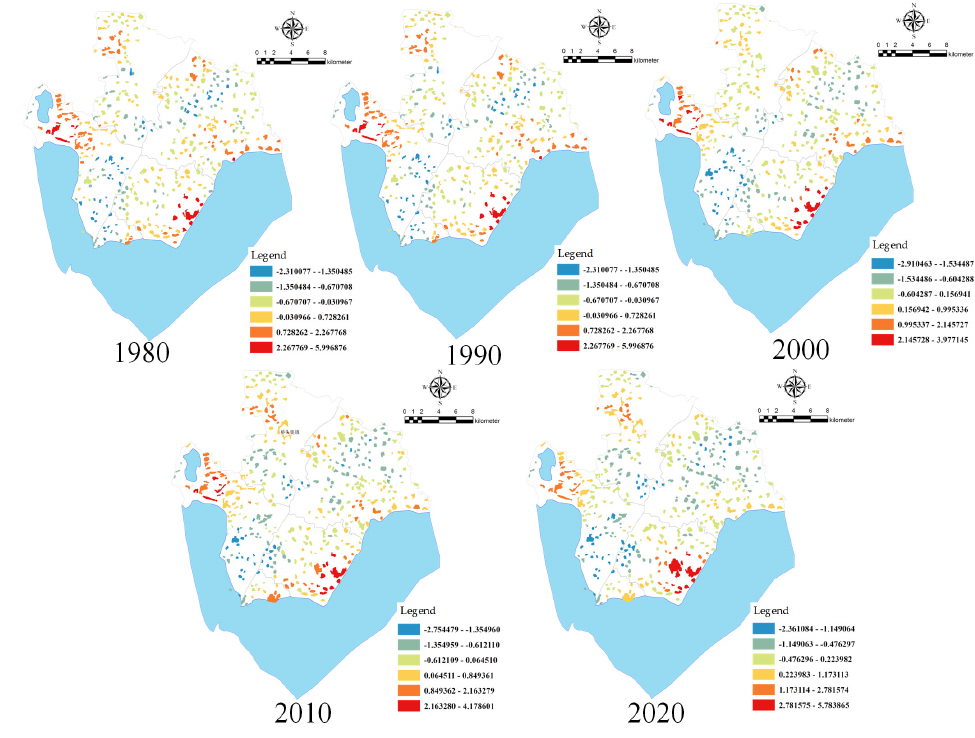
Figure 4. A “hotspot” map of the size of rural settlements on the Chaohu